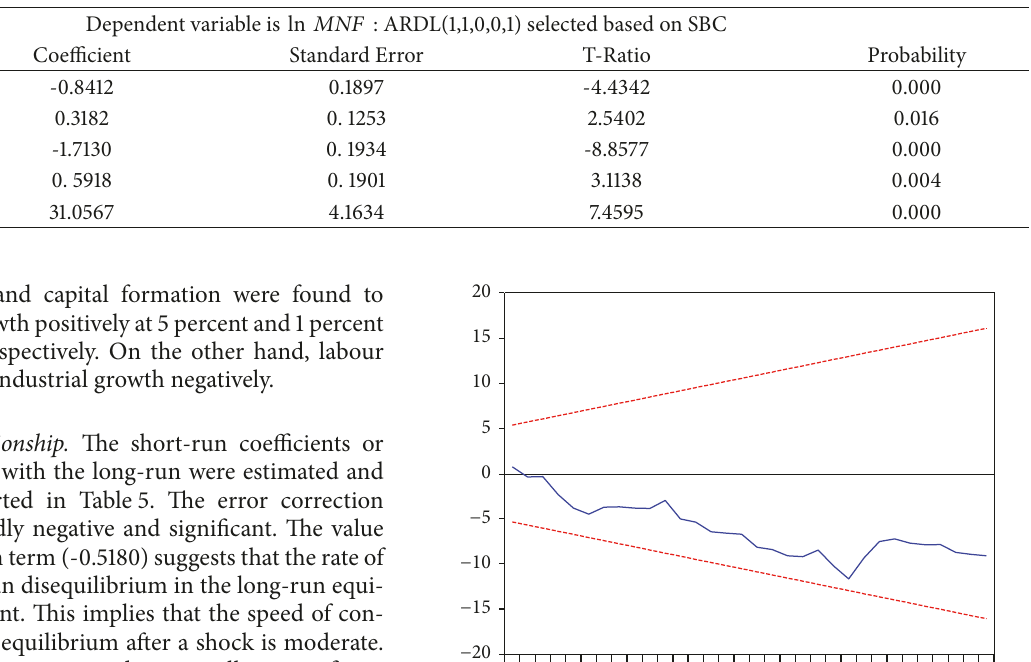
Table 4: Long-run coefficients.